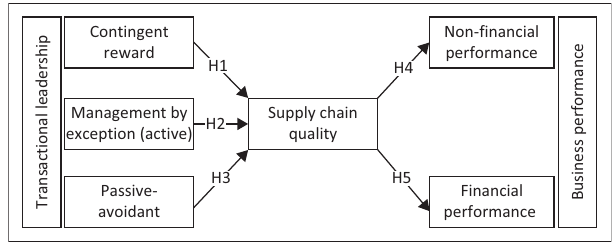
FIGURE 1: Conceptual model for the